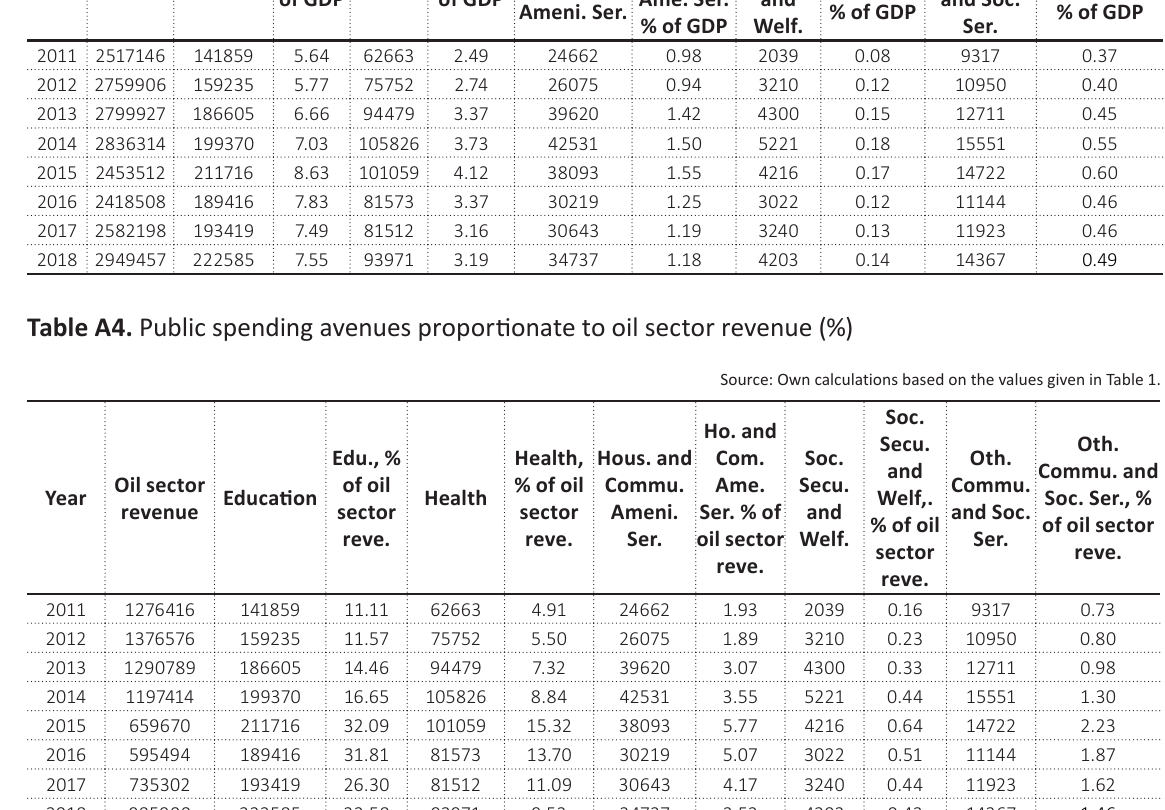
Table A3. Public spending avenues proportionate to GDP (%)